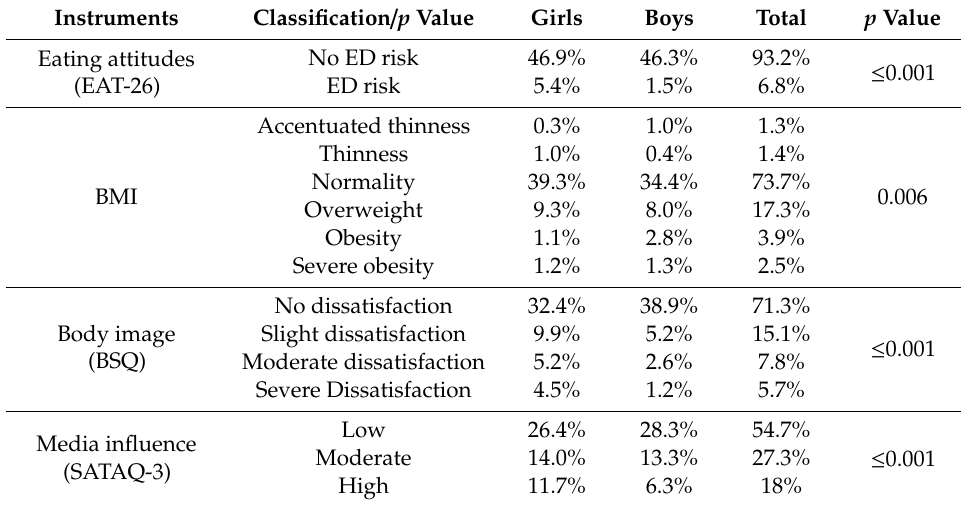
Table 2. Classification of adolescents for eating disorders risk, body mass index (BMI), body dissatisfaction, and mass media influence, by gender.